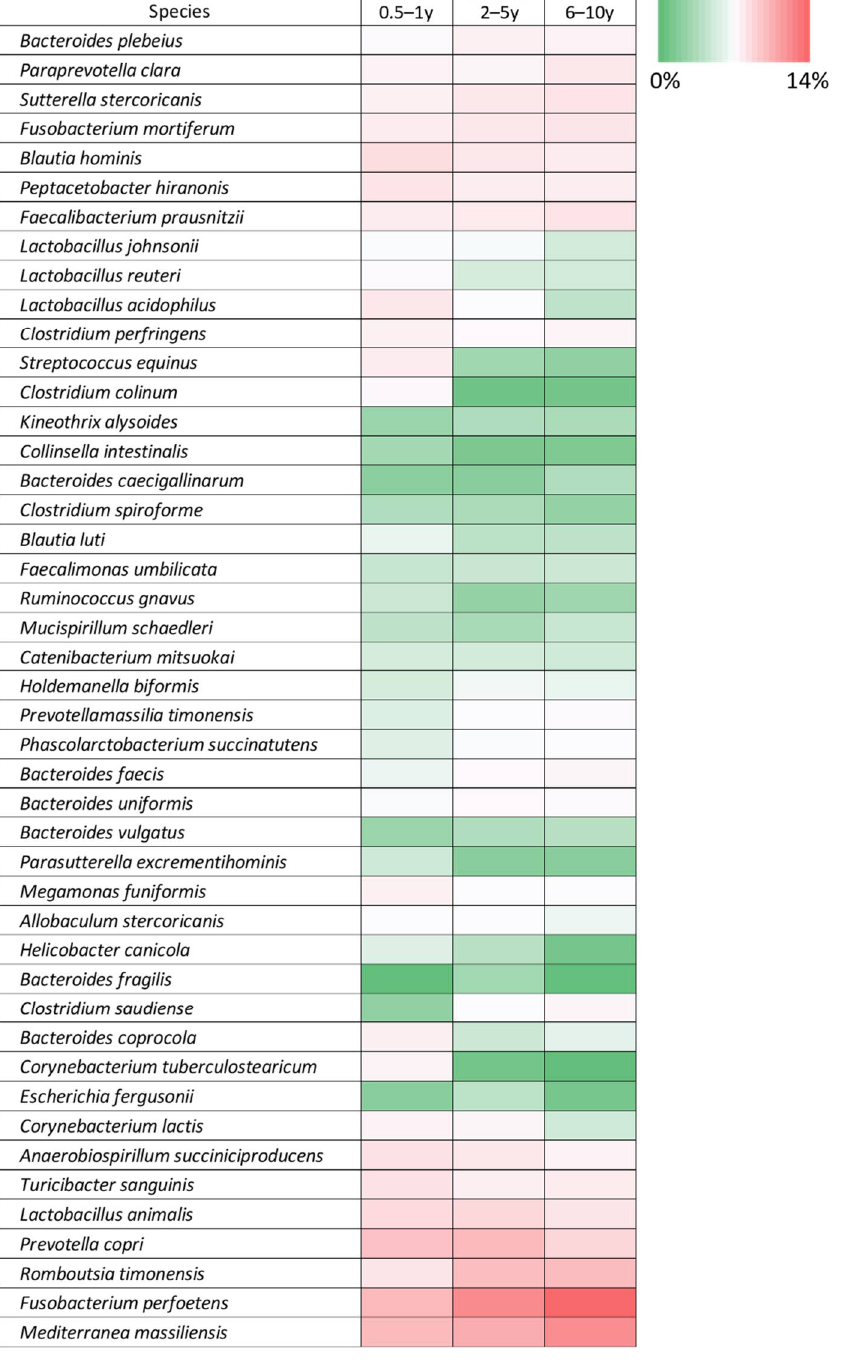
Figure 5. Heatmap of gut microbiota at the species level between different age groups. Color scale based on relative abundance of operational taxonomic unit (OTU). Forty-five core species were included in this analysis.